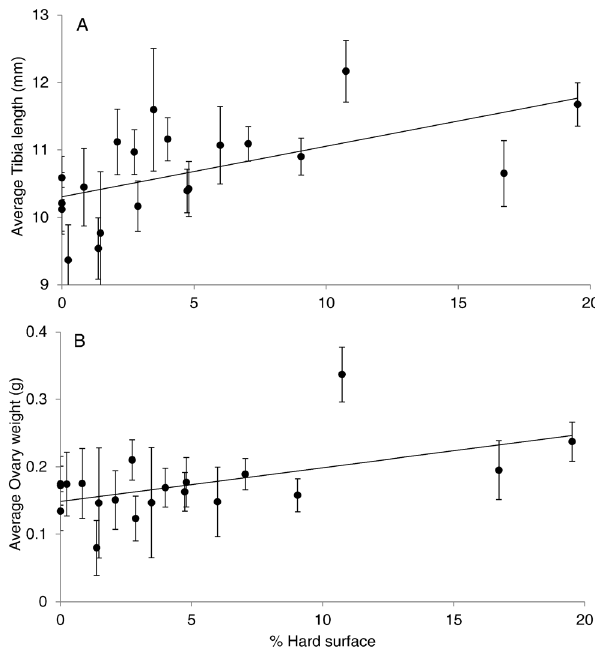
Figure 2. Relationships (site average + / 2 S.E) between the percentage of each site covered in hard surfaces and spider morphology. a) Positive correlation between percentage hard surfaces and the average tibia length (r 2 =0.33, p , 0.01). b) positive correlation between the percentage hard surface and average ovary weight (r 2 =0.30, p=0.01).